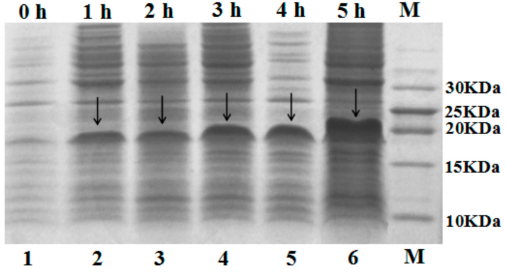
Figure 2. Tricine-SDS-PAGE analysis of supernatant with 1.5 mM IPTG induction. Lane 1, supernatant of non-induced E. coli BL21 (DE3); Lane 2, 3, 4, 5, 6 were supernatant of 1.5 mM IPTG-induced E. coli BL21